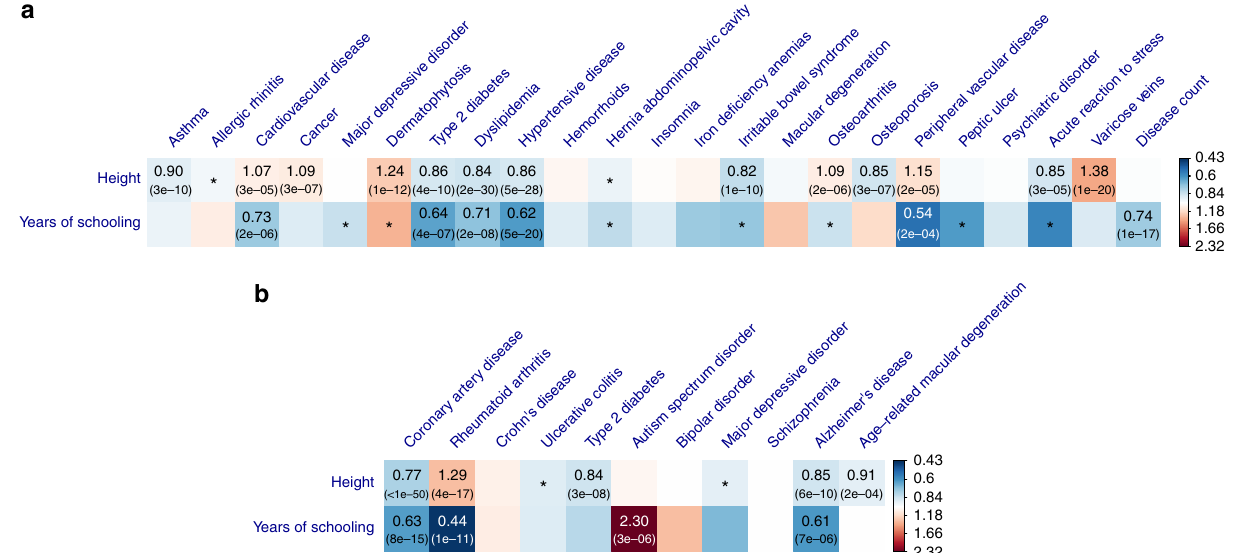
Fig. 6 Effects of height and educational attainment on common diseases. Shown are the results from GSMR analyses with disease data a from a meta- analysis of the GERA and UKB studies and b from published independent case – control studies. Colors represent the effect sizes (as measured by odds ratios, ORs) of risk factors on diseases, red for risk effects and blue for protective effects. The signi fi cant effects after correcting for multiple testing ( P GSMR < 7.6×10 − 4 ) are labeled with ORs ( P -values). The nominally signi fi cant effects ( P Table 12). It showed protective effect against PVD (OR = 0.54), hypertensive diseases (OR = 0.62), T2D (OR = 0.64), dyslipidemia (OR = 0.71) and CVD (OR = 0.73) in the community data, and RA (OR = 0.44), AD (OR = 0.61) and CAD (OR = 0.63) in the